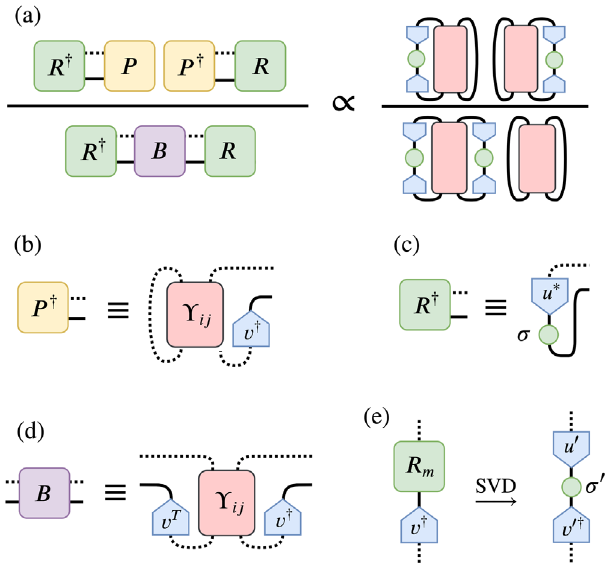
FIG. 10. Tensor diagrams representing some of the steps involved in finding the isometries ˜ u and ˜ v and the bond matrix ˜ σ , which maximize the fidelity between the truncated and untruncated bonds. In panel (a), the Rayleigh quotient in R is FIG. 9. (a) Effective environment E HS of the tensors at proportional to F 2 . Panel (b) shows that P is the contraction of j;l neighboring sites j and l . (b) Bond environment ϒ , which is the bond environment ϵ and the isometry v . In panel (c), we j;l j;l and the updated tensors A 0 and A 0 with the contraction of E HS show that R is the contraction of the bond matrix σ and the j j;l l enlarged bonds f D 0 g ≥ D . In panels (c) – (e), using ϒ j;l , the terms isometry u . Panel (d) shows that B is the contraction of ϒ j the isometry v . In panel (e), the new (primed) isometries are found in the fidelity between the truncated ( ϕ ) and untruncated ( ρ ) by singular value decomposition of the contraction of the density matrices are calculated by contracting with the isometries u , v and the bond matrix σ . maximal eigenvector R and v m